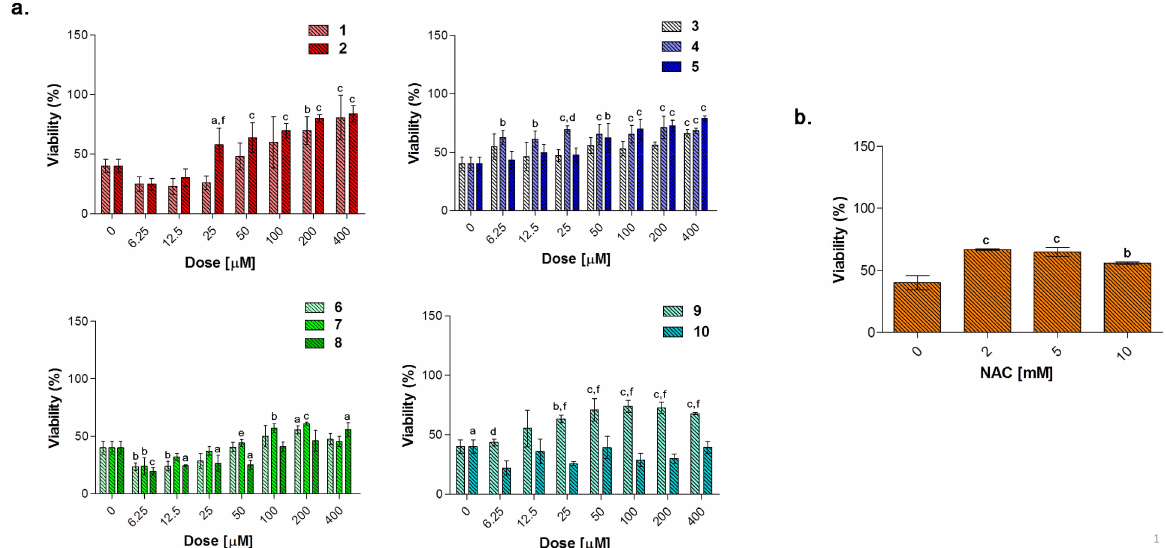
Figure 8. Cell metabolic activity of lipopolysaccharide (LPS)-stimulated (0.1 µ g/mL) RAW 264.7 mouse macrophages in the presence of increasing concentrations (0–400 µ M) of compounds 1 – 10 ( a ) and NAC ( N -acetyl cysteine) (0–10 mM) ( b ) after 24 h. Data shown are the means ± S.D. of six replicates and are expressed as percentages of untreated cultures set as 100% (not shown). The 0 µ M concentration represents cells stimulated with 0.1 µ g/mL alone. (a = p < 0.05 between compounds or NAC and cells exposed to LPS alone; b = p < 0.01 between compounds or NAC and cells exposed to LPS alone; c = p < 0.001 between compounds or NAC and cells exposed to LPS alone; d = p < 0.05 between compounds at the same concentration; e = p < 0.01 between compounds at the same concentration; f = p < 0.001 between compounds at the same